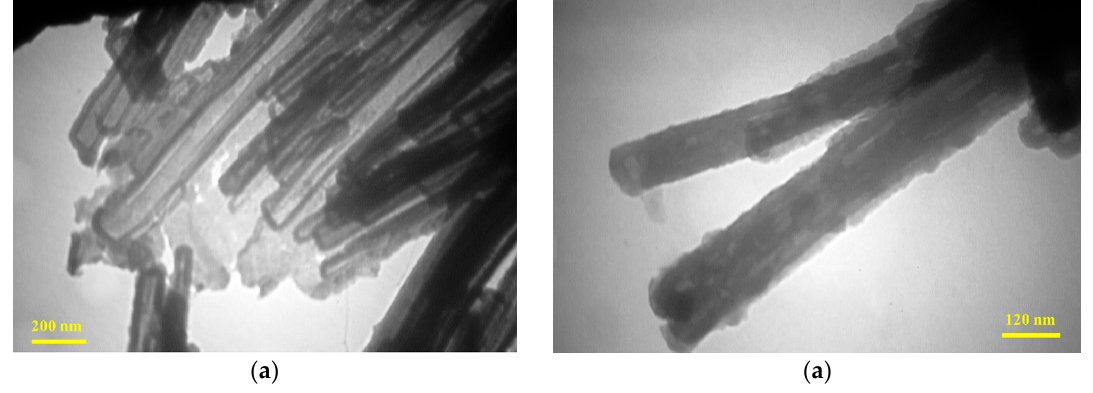
Figure 10. TEM images ( a , b ) of synthesized PPy nanotubes with two different magnitudes. Reprinted from [13]. Copyright (2017), with permission from Elsevier.